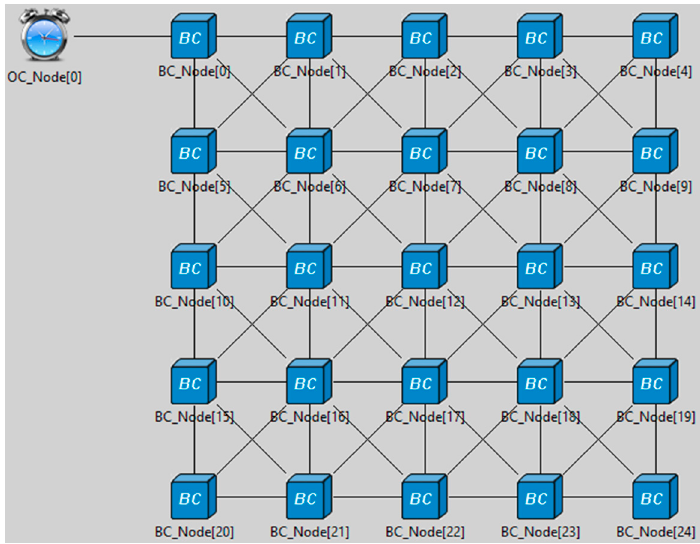
Figure 9. The network of simulation 1 using OMNeT++ simulator.